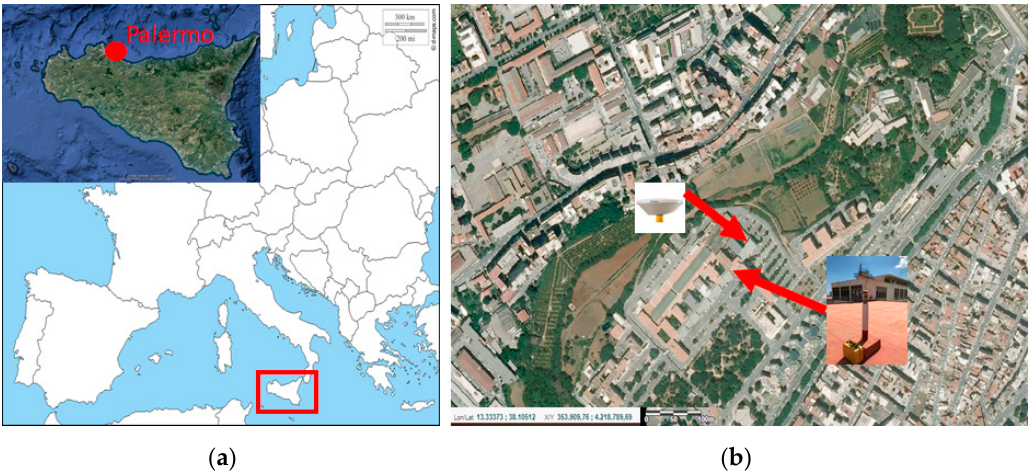
Figure 1. ( a ) Geographical position of the study area; ( b ) digital orthophoto from Italian National Geoportal, scale 1:4000, reference system UTM-WGS8433N (ETRF2000); position of Trimble permanent station and Topcon HiPer HR on a concrete pillar.